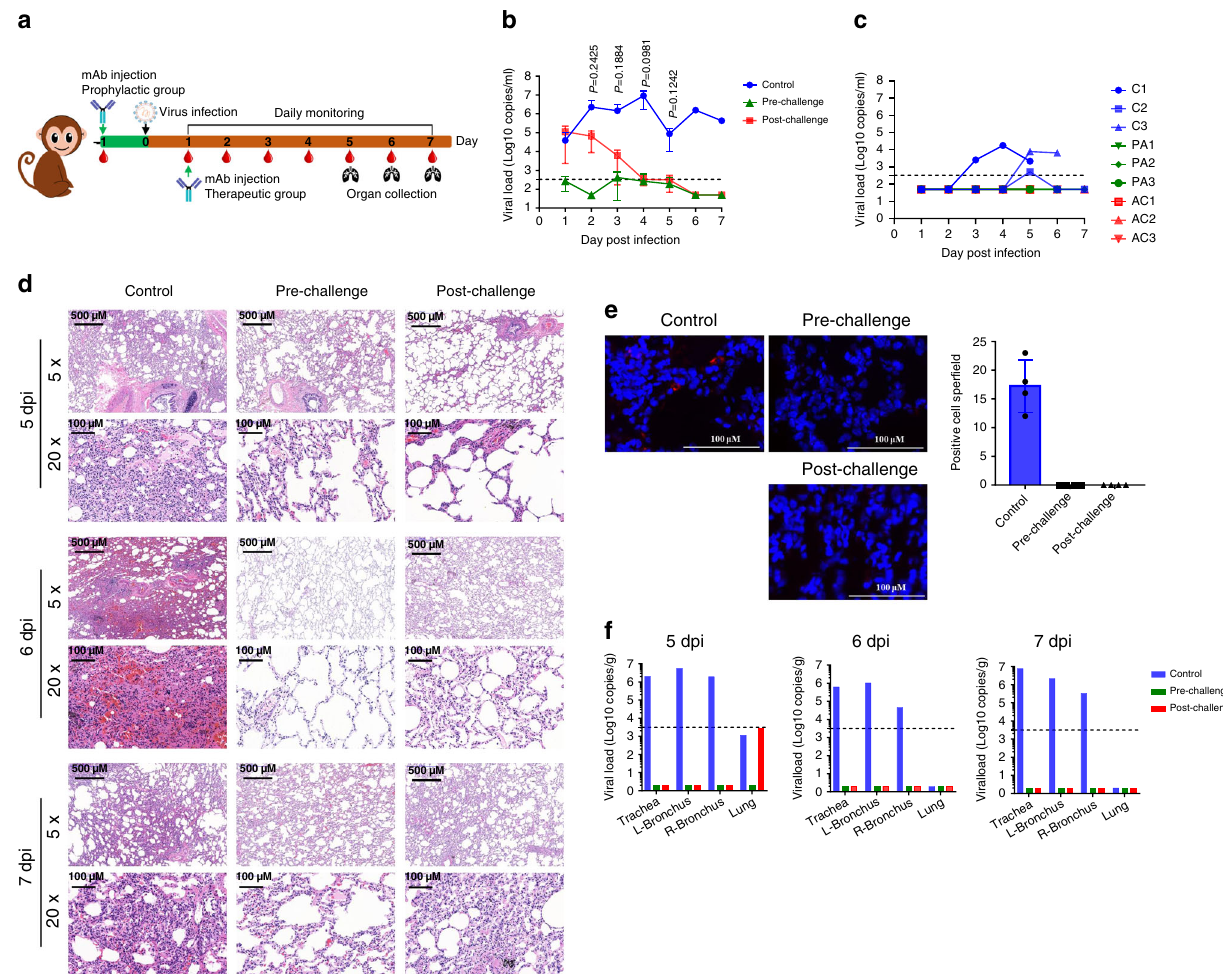
Fig. 4 Prophylactic and therapeutic effects of MW05/LALA. a A schematic of the experimental in vivo set up. Nine rhesus monkeys were divided into pre-challenge (prophylactic), post-challenge (therapeutic), and control groups with three animals in each group. Before virus challenge, the monkeys in the pre-challenge group were injected intravenously with a single dose of 20 mg/kg MW05/LALA. One day later, all monkeys were challenged with 1 × 10 5 TCID 50 SARS-CoV-2 via intratracheal intubation. A single dose of 40 mg/kg MW05/LALA was administered to each animal in the post-challenge group on day 1 post-challenge. Monkeys in the control group were given 20 mg/kg irrelevant hIgG1 one day before virus challenge. b Viral titers of oropharyngeal swabs at the indicated time points were evaluated using qRT-PCR. Data are average values from three monkeys ( n = 3) for the fi rst 5 days, from two monkeys ( n = 2) for 6 dpi, and from one monkey ( n = 1) for 7 dpi. The dotted line for limit of detection (200 copies/ml) is labeled. Statistical signi fi cance was calculated via unpaired two-tailed t- test. P values at different time points are labeled. c Viral titer of rectal swabs at the indicated time points were evaluated by qRT-PCR. C indicates the control group, PA the pre-challenge group, and AC the post-challenge group. The dotted line for limit of detection (200 copies/ml) is labeled. d Histopathology and immunohistochemical examination of lung tissues from pre-challenge, post-challenge, and control monkeys. Two biological replicates were performed. e Immuno fl uorescence analysis of SARS-CoV-2 protein expression in lung tissues from pre-challenge, post-challenge, and control monkeys. Four fi elds were checked for each group. The average ± SD of n = 4 from two independent experiments is shown. Two biological replicates were performed. f Viral load analysis of trachea, bronchus, and lung tissues of experimental animals. L-Bronchus left bronchus, R- Bronchus right bronchus. The dotted line for limit of detection (10 3.5 copies/g) is labeled. each lobe. There was a dark red hemorrhage lesion (2 cm × 4 mm) texture; a hemorrhage point was noted at the edge of the left- in the right-lower lobe, while no obvious abnormalities were lower lobe. On 7 dpi, the lungs of animal PA-2 appeared pink; the observed in other areas. On 7 dpi, the lungs of animal C-2 lobes were scattered with macroscopically visible black spots; appeared whitish pink, and there were scattered hemorrhage there was a white translucent membrane-like structure at the tip spots of different sizes in the left-lower lobe, right-upper lobe, of the right-lower lobe, indicative of potential lung-pleural right-middle lobe, and right-lower lobe. Dark pink hemorrhagic adhesion, while no other obvious abnormalities were observed lesions were observed in the left- and right-lower lobe margins (Supplementary Fig. 11). The color of lungs of therapeutic animal (Supplementary Fig. 11). The color of lungs of prophylactic AC-1 sacri fi ced at 5 dpi appeared pink in color; the surface of the animal PA-1 sacri fi ced at 5 dpi appeared pink, and no obvious lobes were scattered with macroscopically visible congestion abnormalities were observed in the gross necropsy. On 6 dpi, the points, and no other obvious abnormalities were observed. On 6 lungs of animal PA-3 appeared pink; a rust-colored lesion was dpi, the lungs of animal AC-3 appeared whitish pink, with visible noted at the tip of the left-middle lobe with relatively hard black spots scattered on each lobe; a dark red (5 cm × 2 mm) NATURE COMMUNICATIONS| (2020) 11:5752